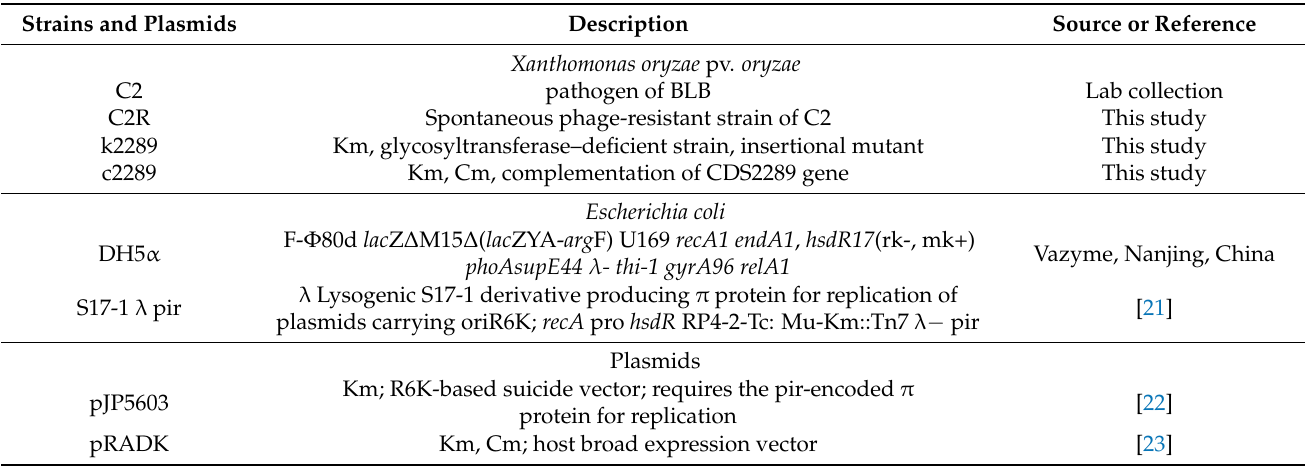
Table 1. Strains and plasmids used in this